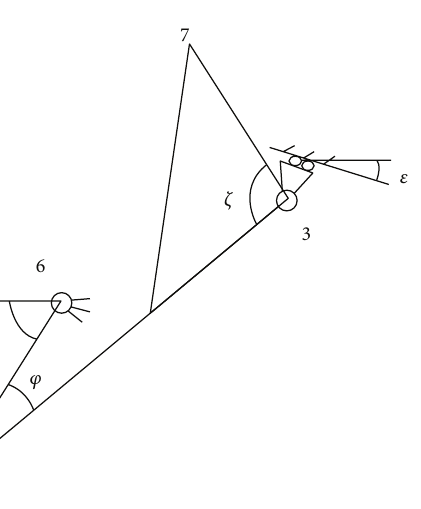
Figure 10. The design is composed of one motor that transmits power to both left and right